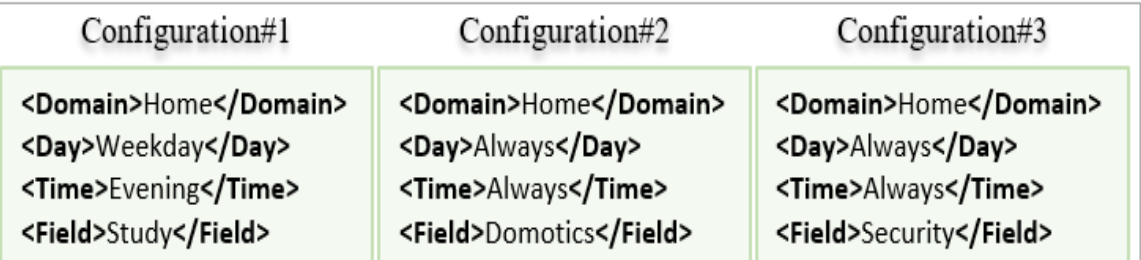
Figure 9. Explicit preferences for the first scenario.